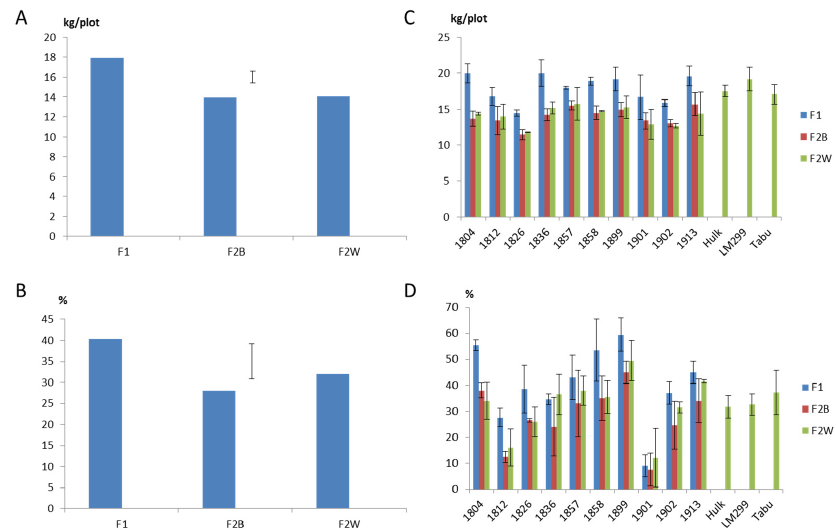
Figure 1. ( A ) Predict mean of different generations on total fresh herbage yield including LSD bar at p = 0.05. ( B ) Predict mean of different generations on survival rate including LSD bar at p = 0.05. ( C